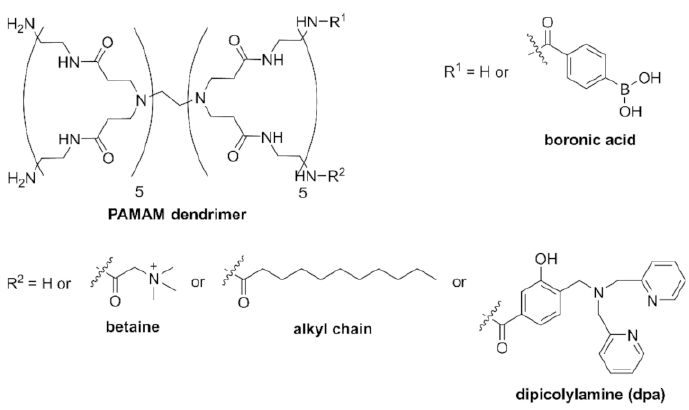
Figure 1. Structures of PAMAM dendrimer